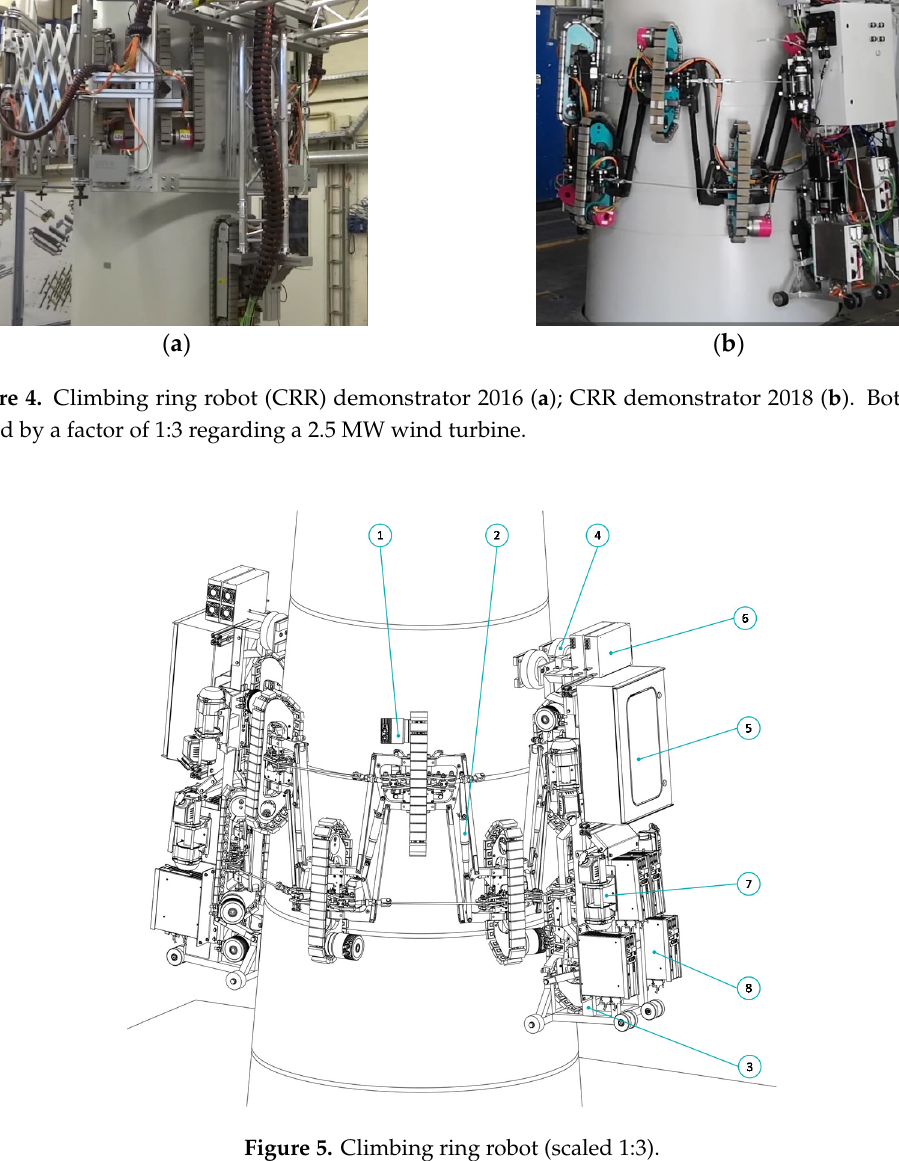
Table 1. Finite element method for the two cross-connection concepts.